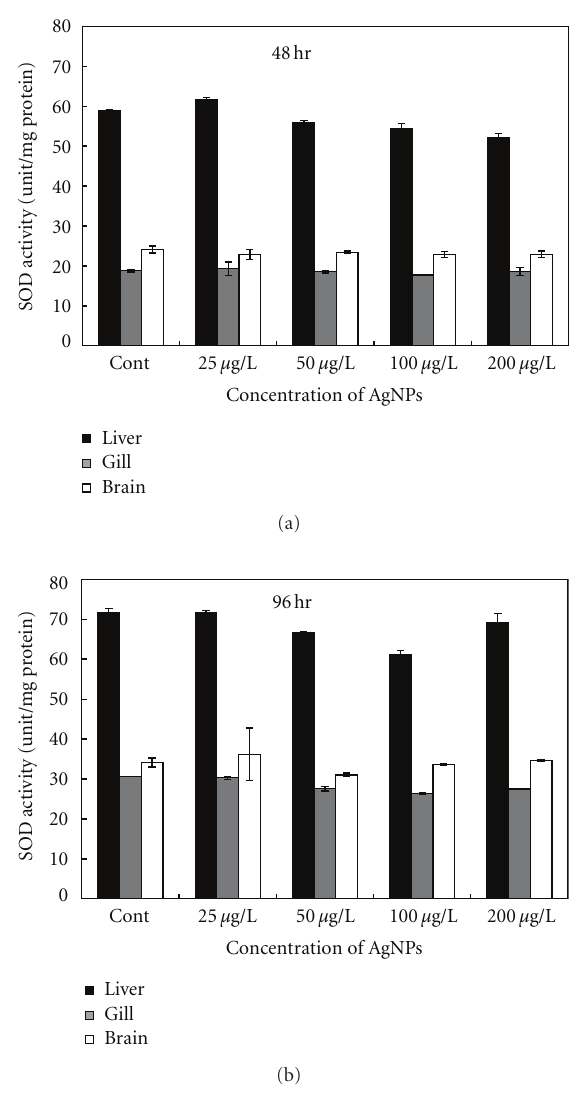
Figure 4: SOD activity in di ff erent organs of the common carp exposed to various concentrations of Ag-NPs at (a) 48 h and (b) 96h.